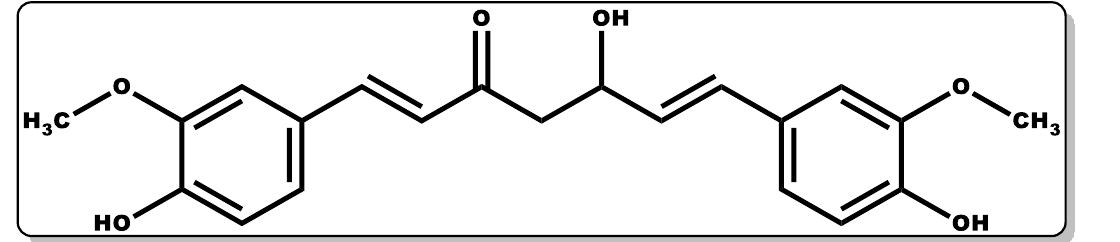
Figure 4. Molecular structure of (1E,6E) – 1,7 – Bis(4 – hydroxy – 3 – methoxyphenyl)hepta – 1,6 – diene – 3,5 – dione (Curcumin). dione